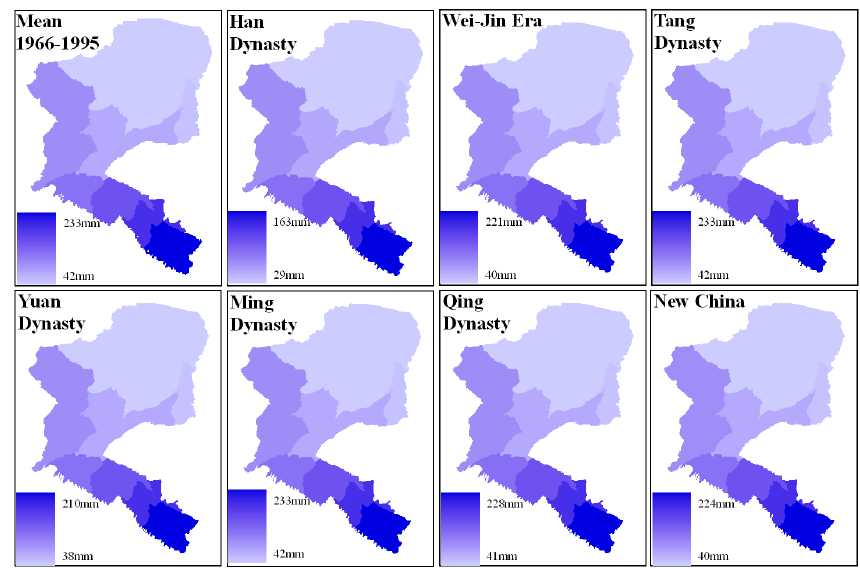
Figure 2. The reconstructed precipitation in historical periods in midstream and downstream areas of the